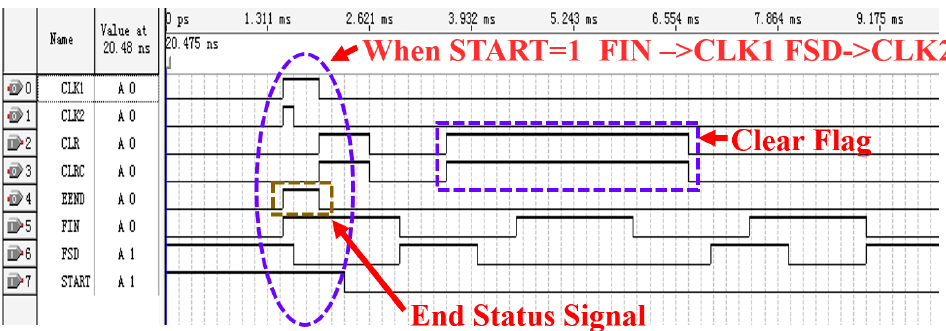
Figure 12. Frequency measurement/cycle control circuit.